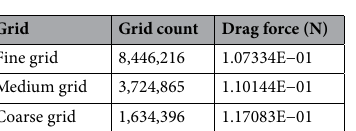
Table 1. Grid independence study of free-swimming remora in 1